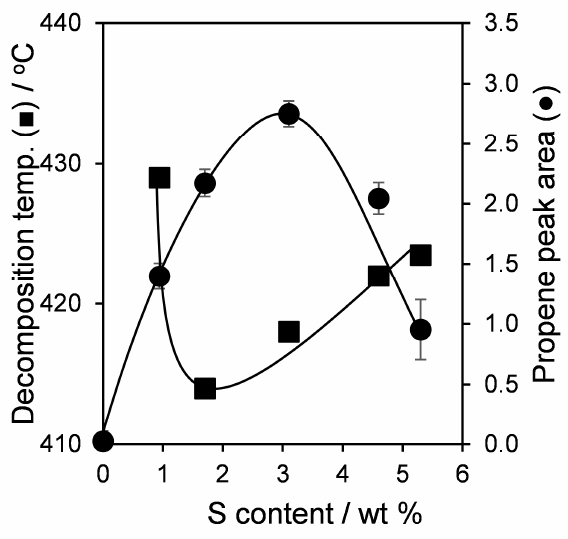
Figure 7. Desorption temperature and peak area for reactively-formed propene from parent and sulfated zirconia as a function of bulk S loading.